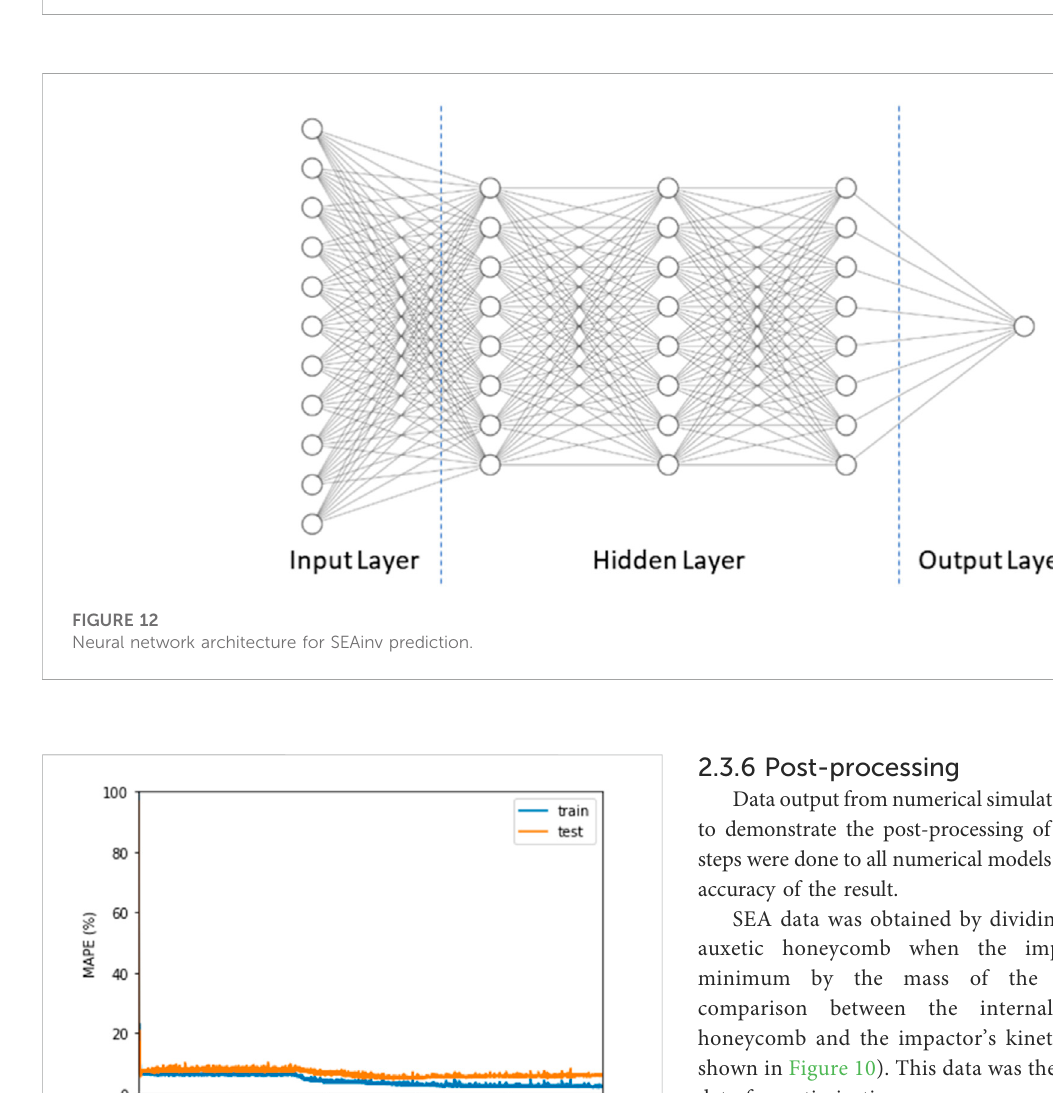
Battery ’ s von Mises Stress vs. time of system model no. 1.